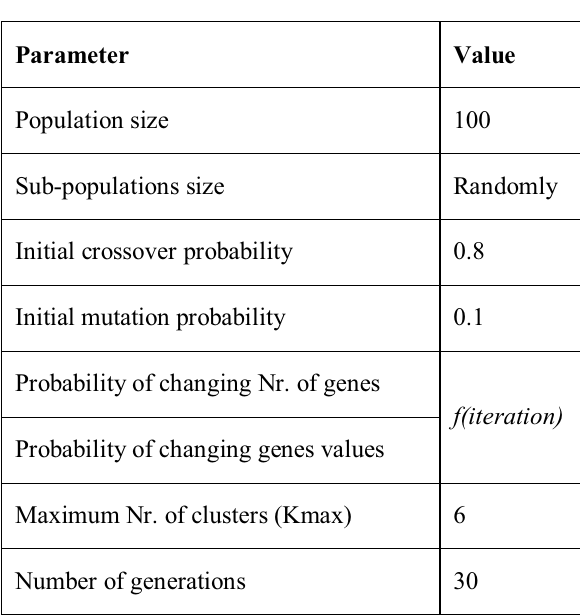
Table 1. Configuration parameters for the proposed